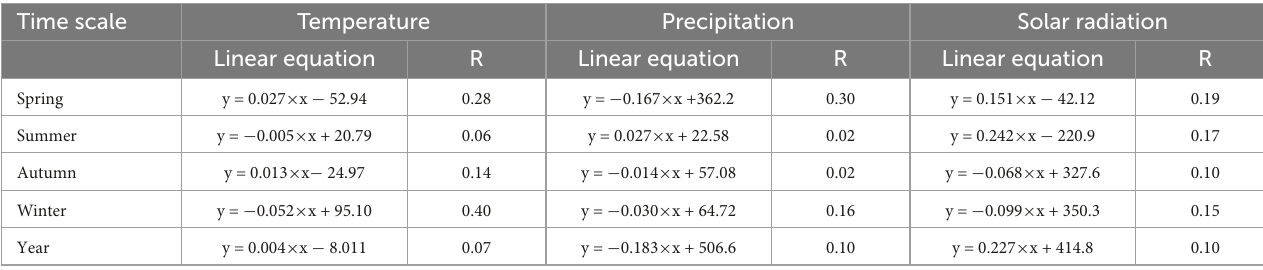
TABLE 1 The climate tendency rate statistical results of climate factor from 2000 to 2015.